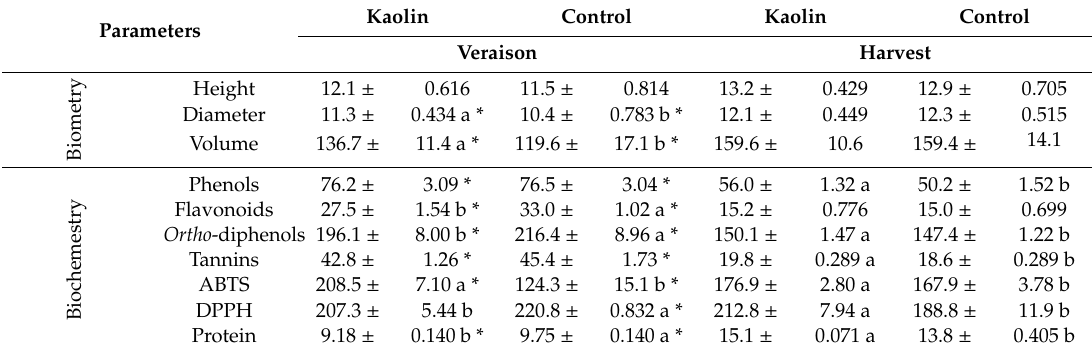
Table 4. Kaolin application e ff ect on height (mm), diameter (mm), and volume (mm 3 ) of